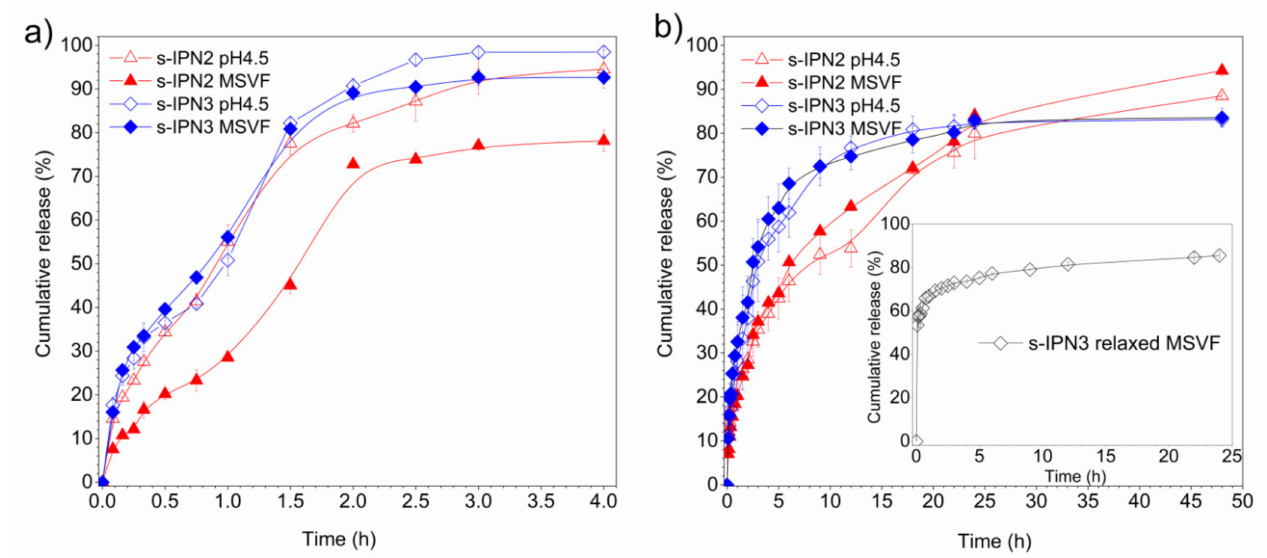
Figure 9. Release kinetics of MTZ from s-IPN 2 and s-IPN 3 in buffer pH 4.5 and MSVF media, at 25 ◦ C ( a ) and 37 ◦ C ( b ). Inset ( b ) shows release profiles from s-IPN 3 in an initial relaxed state. The experimental points were joined using a spline line